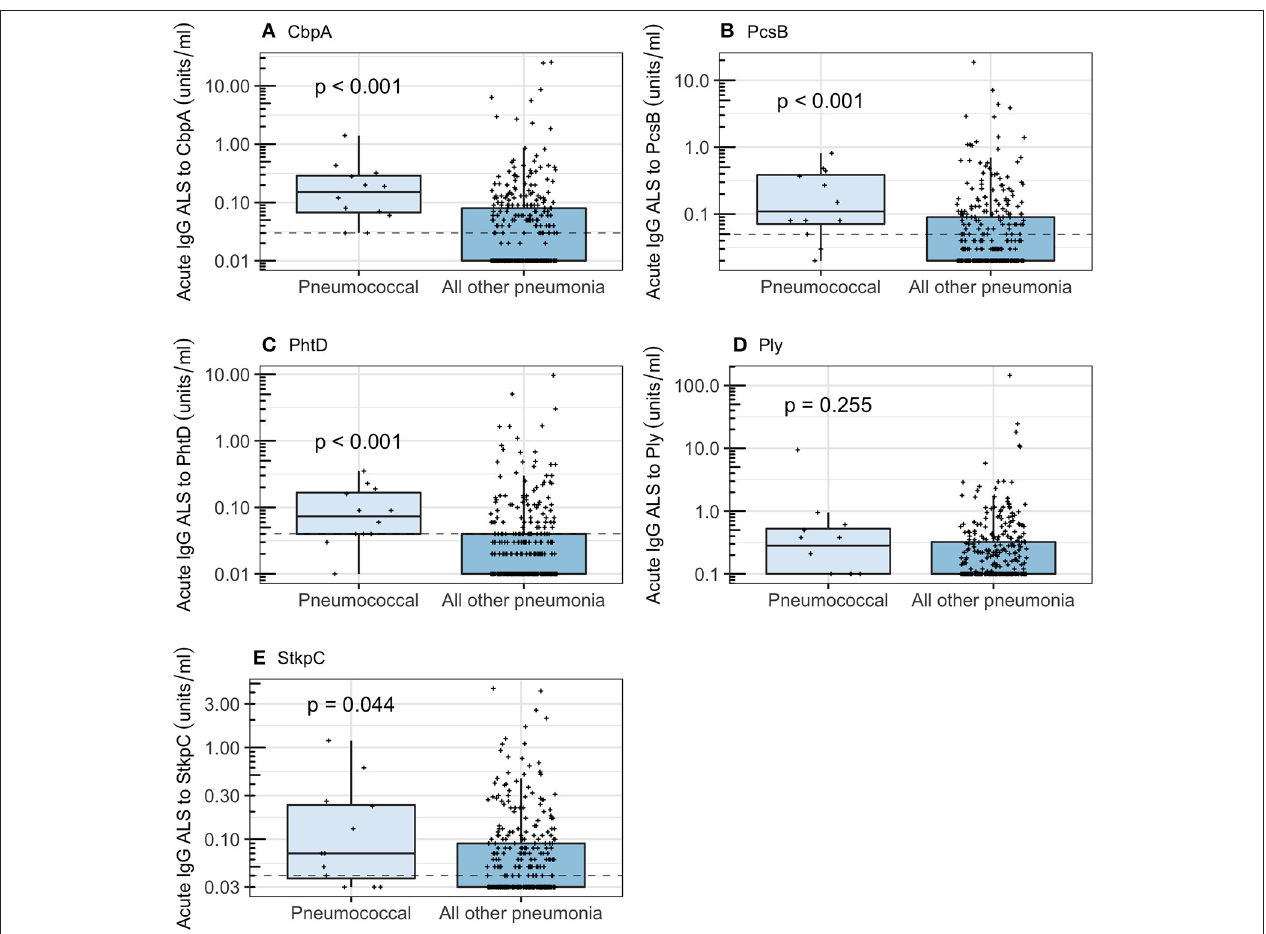
FIGURE 3 | Acute IgG ALS to pneumococcal proteins by children with pneumococcal pneumonia and all other pneumonia in children enrolled into the study. Dashed horizontal lines represent thresholds derived from the Youden Index, p -values were derived from the Wilcoxon rank sum test. For all box and whisker plots: the solid line represents the median value, lower hinge 25th centile, upper hinge 75th centile, and whiskers represent 1.5 times the interquartile range. All data points have also been plotted. (A) Choline binding protein A (CbpA); (B) protein for cell wall separation of group B streptococci (PcsB); (C) pneumococcal histidine triad D (PhtD); (D) pneumolysin (Ply); (E) serine threonine kinase protein C